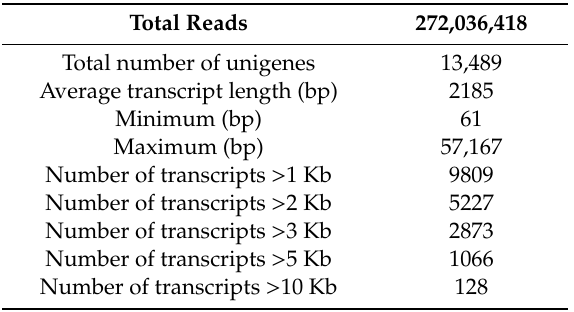
Table 1. Summary of the B. dorsalis early embryo transcriptome.